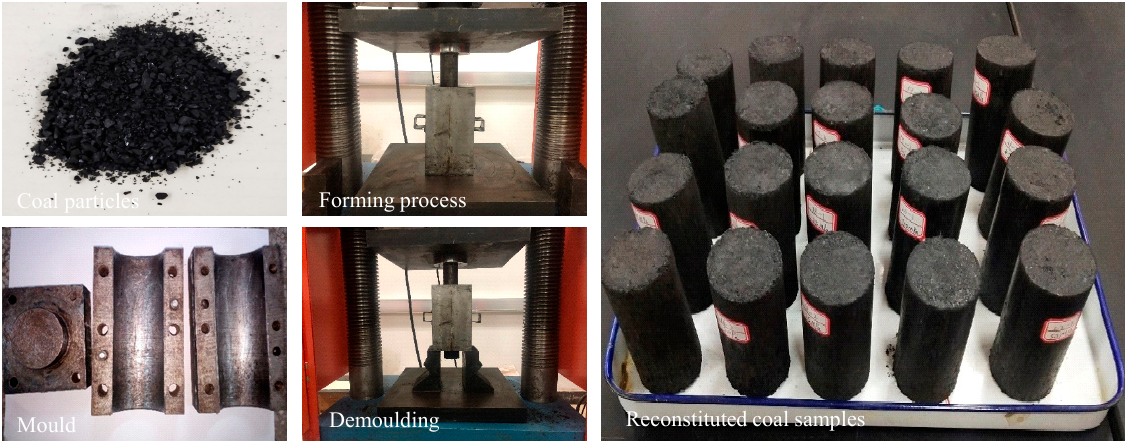
Figure 3. Preparation of RTC samples.